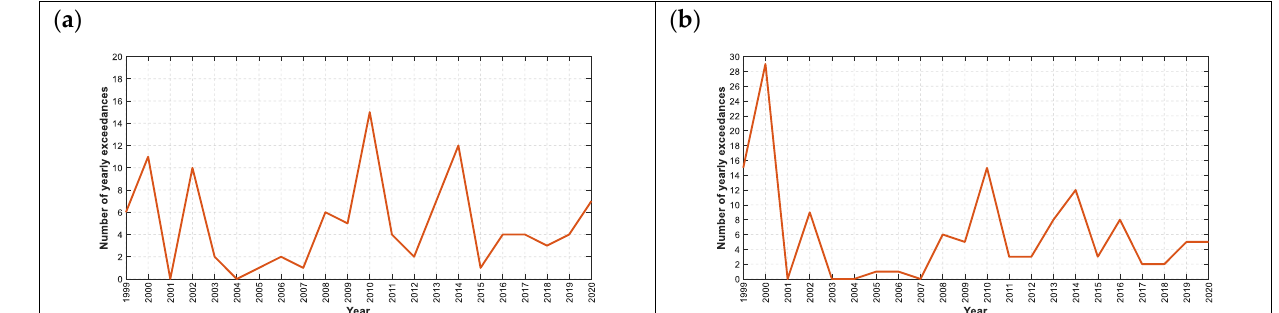
Figure 14. Number of annual exceedances (1999–2020) of the first hydrometric level threshold over the Seveso River basin for Paderno Dugnano ( a ) and Cantù ( b ) gauge sections, respectively. The results lead to the conclusion that there are no relevant trends from a statistical point of view to declare a change in precipitation pattern, and a modification in flow